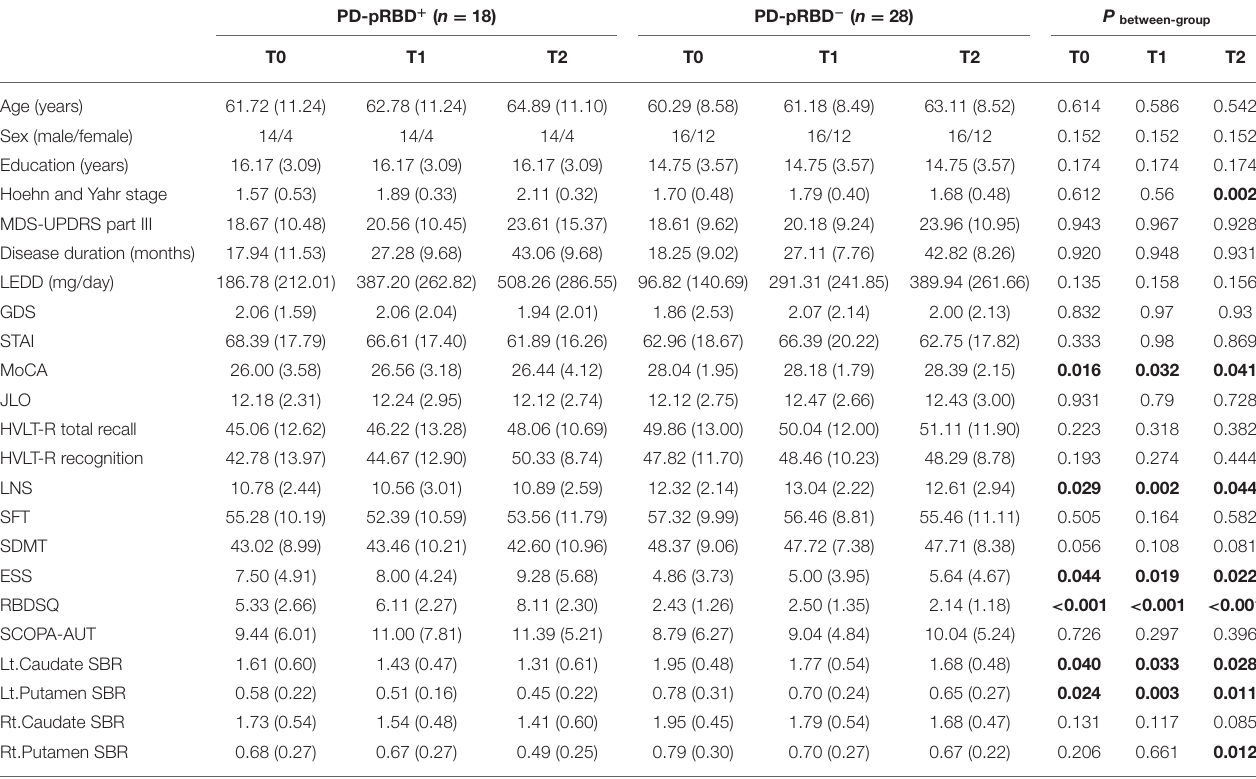
TABLE 1 | Longitudinal demographic characteristics and neuropsychological assessments of PD-pRBD + and PD-pRBD − patients over time. PD-pRBD + ( n = 18) PD-pRBD − ( n =